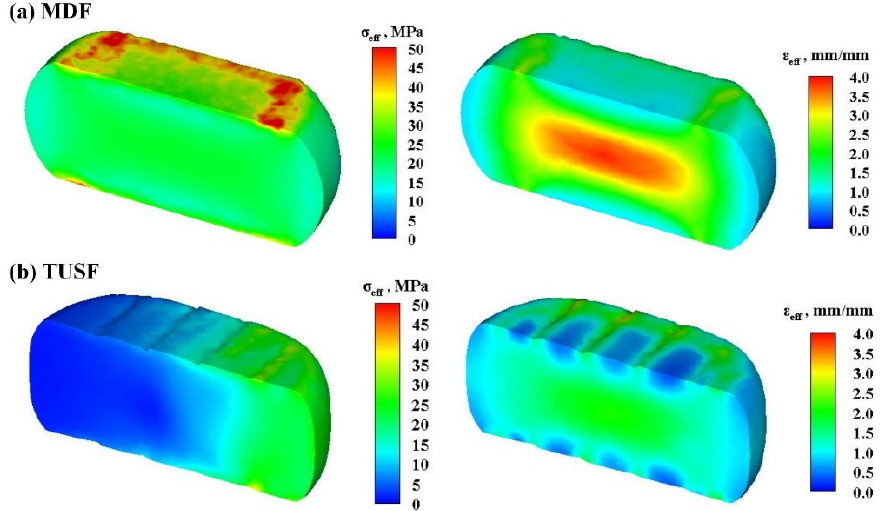
Figure 13. Effective stress and strain distributions of specimens after ( a ) MDF and ( b ) TUSF.